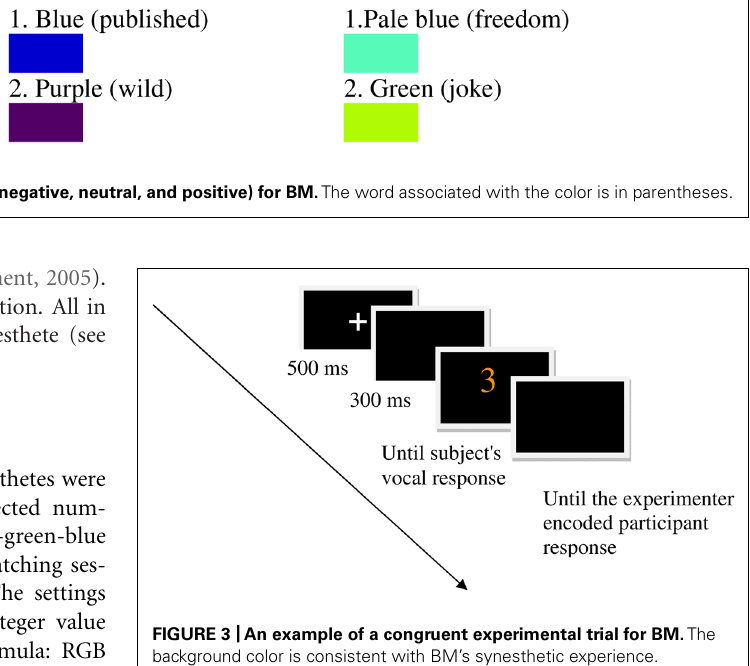
FIGURE 3 |An example of a congruent experimental trial for BM. The background color is consistent with BM’s synesthetic